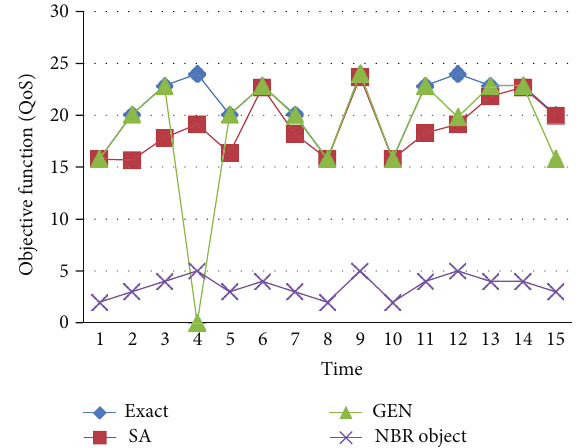
Figure 16: Number Object/QoS variation for exact, genetic (nbr it = 200 ), and simulated annealing ( fact = 0.95) .